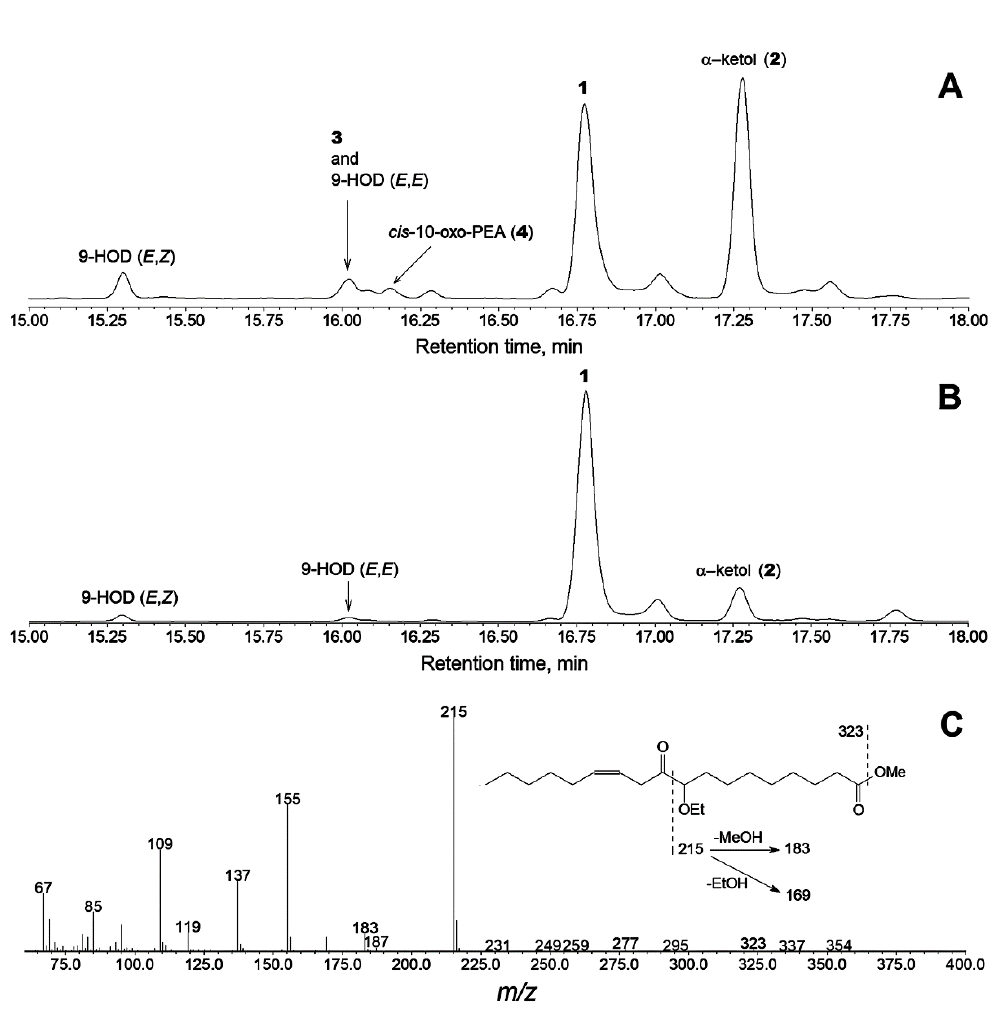
Figure 2. Products of ethanol trapping experiments after the brief incubations of 9-HPOD with LeAOS3 or ZmAOS. The total ion current GC–MS chromatograms of products (Me/TMS) of biphasic (hexane/water 40:1 by volume, 60 s, 0 °C) incubations of LeAOS3 ( A ) and ZmAOS ( B ) with 9-HPOD followed by (1) water freezing, (2) direct addition of ethanol excess to the hexane phase, (3) solvent evaporation, methylation and trimethylsilylation of products and (4) GC-MS analyses of product derivatives. ( C ), the electron impact mass spectrum of the trapping product 1 . Inset, the mass fragmentation scheme. The detailed experimental conditions are described in Materials and Methods.